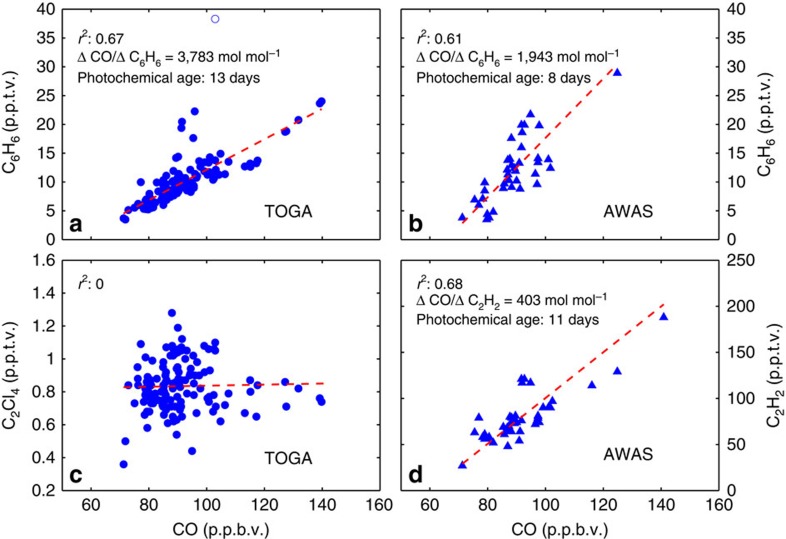
Photochemical age of observed air parcels.Regression of CO against: TOGA C6H6 (a); AWAS C6H6 (b); TOGA C2Cl4 (c); and AWAS C2H2 (d). Data are only for the HOLW structures (O3 >40 p.p.b.v. and RH <20%). The dashed red line is the best fit via orthogonal linear regression. A single data outlier (open circle, a) has been excluded from the analysis. Values of r2 are shown for all panels; enhancement ratios and photochemical ages are shown for panels a, b and d. Excluding the data point for which C6H6 >25 p.p.t.v. for panel b results in an r2 of 0.47, a CO to C6H6 enhancement ratio of 1,823 mol mol−1, and a photochemical age of 7 days.